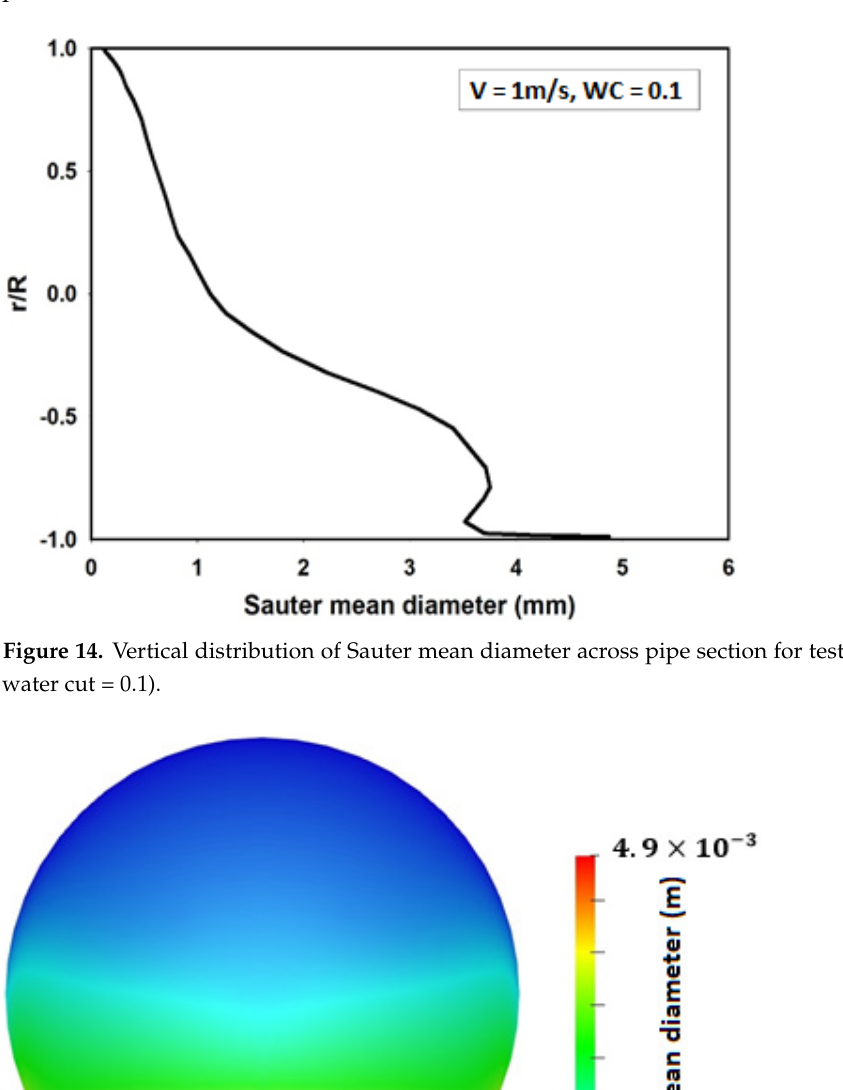
Figure 13. Vertical profile of in situ water volume fraction as measured in the experiment and pre- dicted by CFD model for test 4 (mixture velocity = 1 m/s, water cut = 0.1).